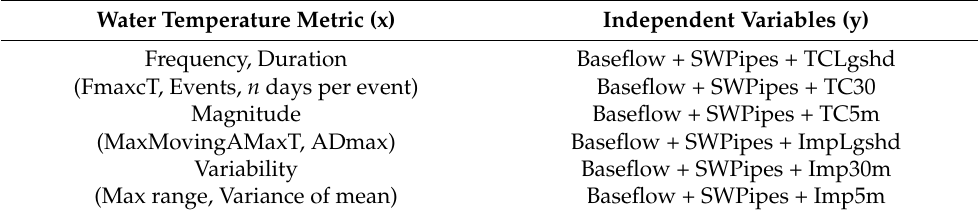
Table 4. Mixed-effects model variables to test hypotheses about effects of baseflow, land cover, and stormwater pipes (y variables) on water temperature metrics (x variables). Hypotheses were tested using datasets separated by land cover type (tree canopy or impervious land cover) and spatial scale (loggershed, 30 m, and 5 m) using a candidate model approach. Water Temperature Metric (x) Independent Variables (y) Frequency, Duration Magnitude (MaxMovingAMaxT, ADmax) Baseflow + SWPipes + ImpLgshd Variability Baseflow + SWPipes + Imp30m (Max range, Variance of mean) Baseflow + SWPipes + Imp5m SWPipes = all stormwater pipes per loggershed; TC = tree canopy; Imp = impervious